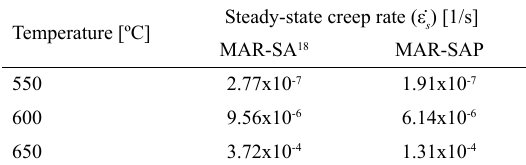
Table 3: Steady-state creep rate (ε̇ at 500 MPa.